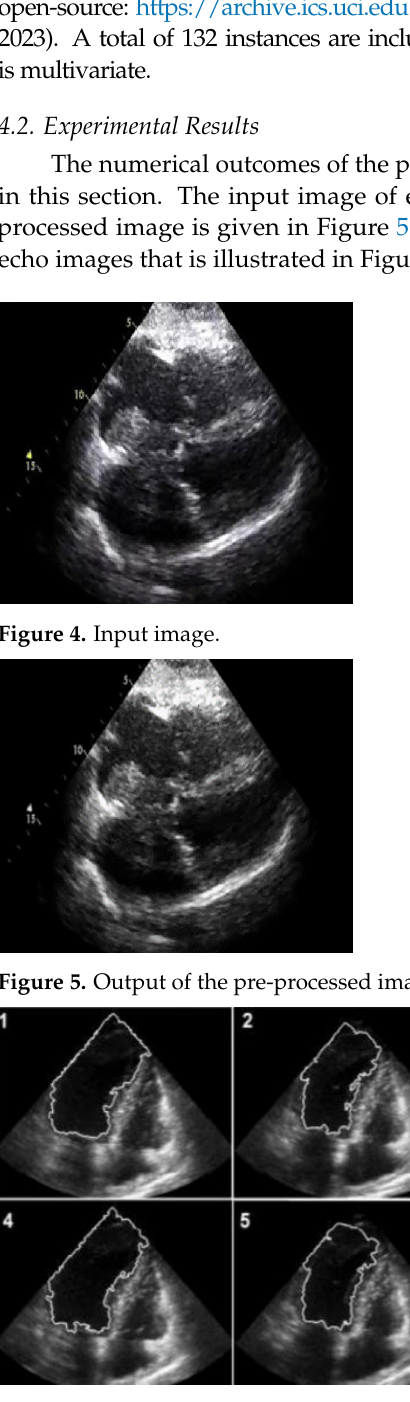
Figure 6. FCM-based segmented